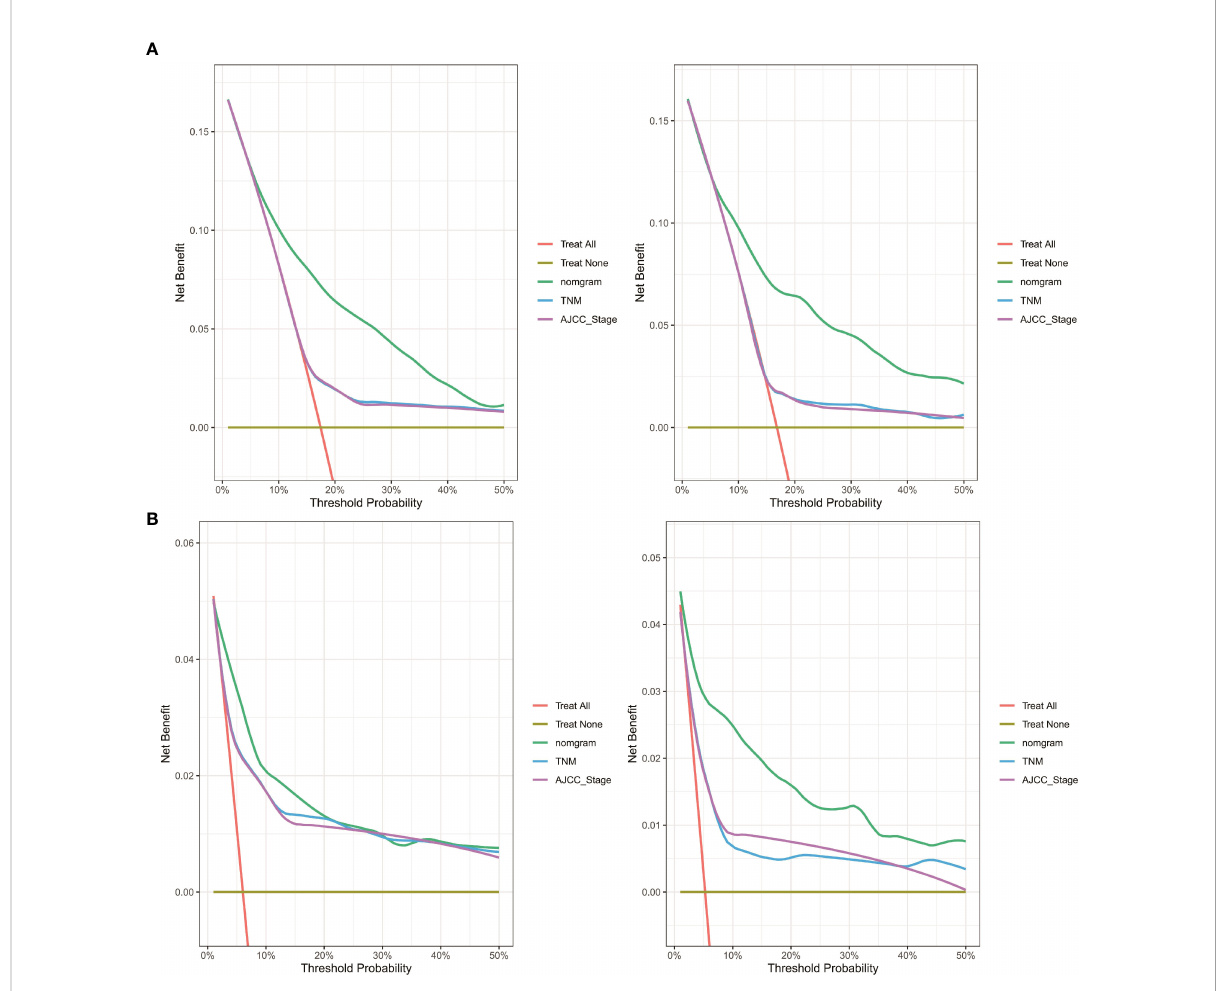
FIGURE 10 DCA curve of the nomogram, AJCC stage and TNM stage for (A) OS and (B) CSS in the training and validation cohort. DCA, decision curve analysis; AJCC, American Joint Commission on Cancer; OS, overall survival; CSS, cancer-speci fi c survival.